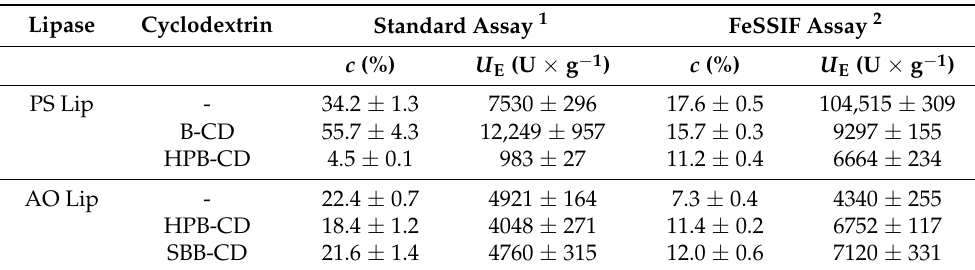
Table 3. Effect of cyclodextrins on the conversion ( c , %) of p -NPP hydrolysis catalyzed by nanofi- brous formulations of lipase from Burkholderia cepacia (PS Lip) and from Aspergillus oryzae (AO Lip), and on the specific enzyme activity ( U E , U × g − 1 ) after 5 min in standard lipase assay and assay in FeSSIF system. Lipase